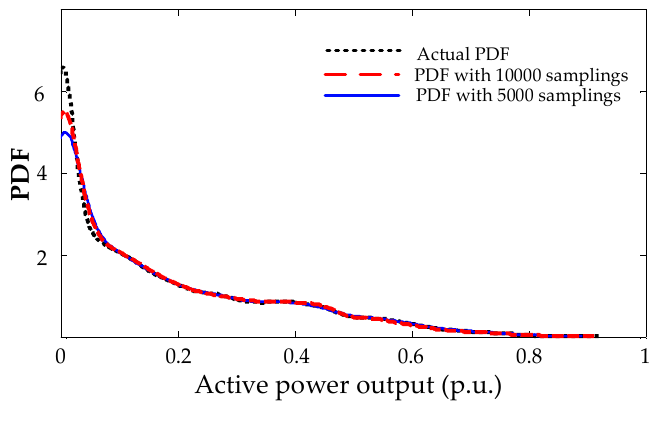
Figure 6. PDF of sampling values.